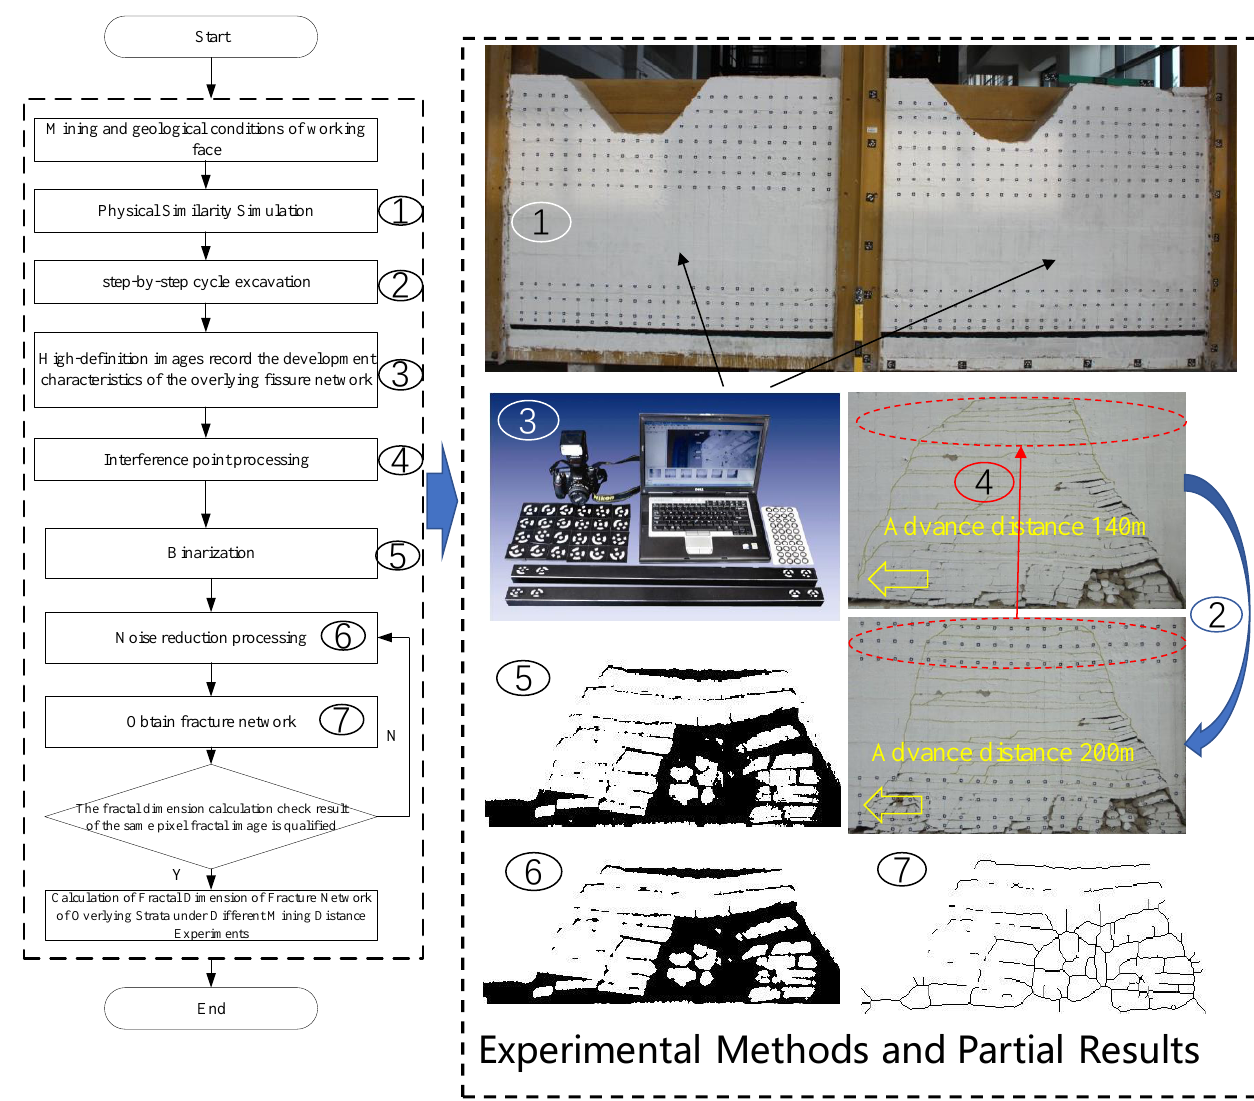
Figure 4. Analysis method flow and partial results of fractal characteristics and evolution law of overlying fissures. Table 4. Extraction of overlying rock fracture network with different mining heights.